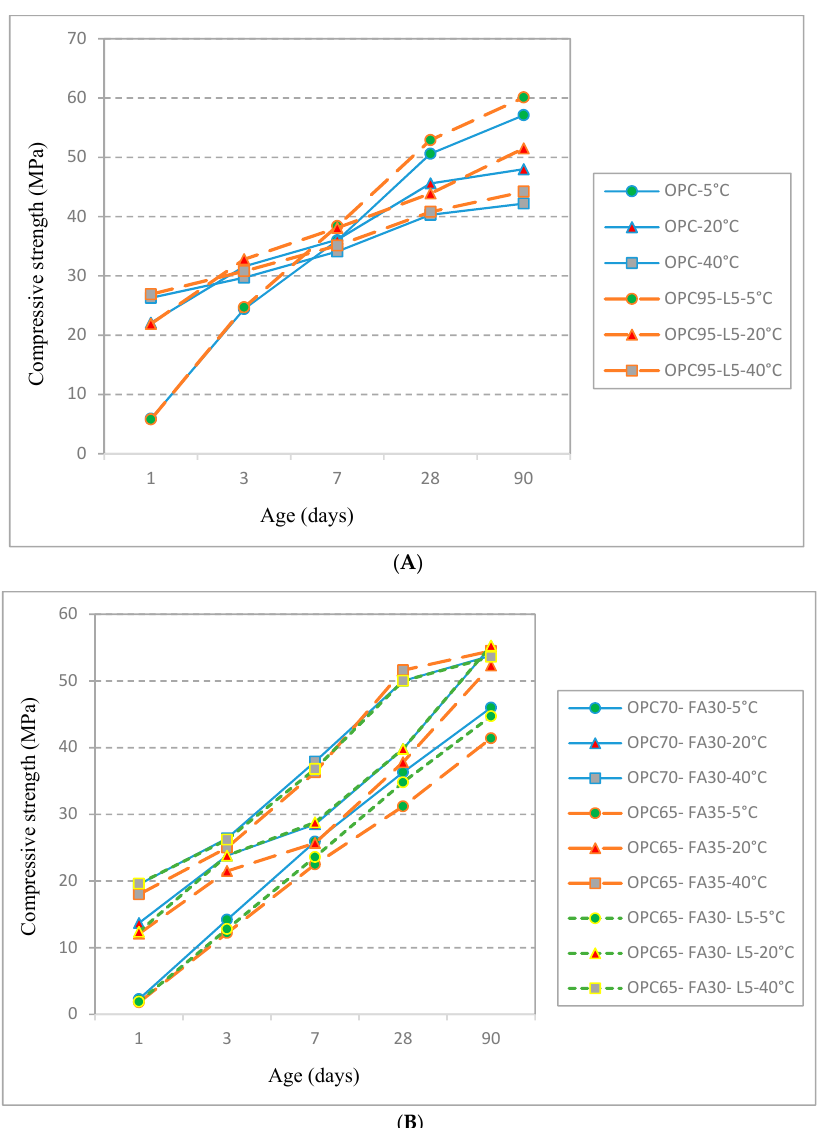
Figure 7. Compressive strengths (MPa) of ( A ) OPC and OPC95-L5; ( B ) OPC70-FA30, OPC65-FA35 and OPC65-FA30-L5 for water curing temperatures of 5 °C, 20 °C and 40 °C